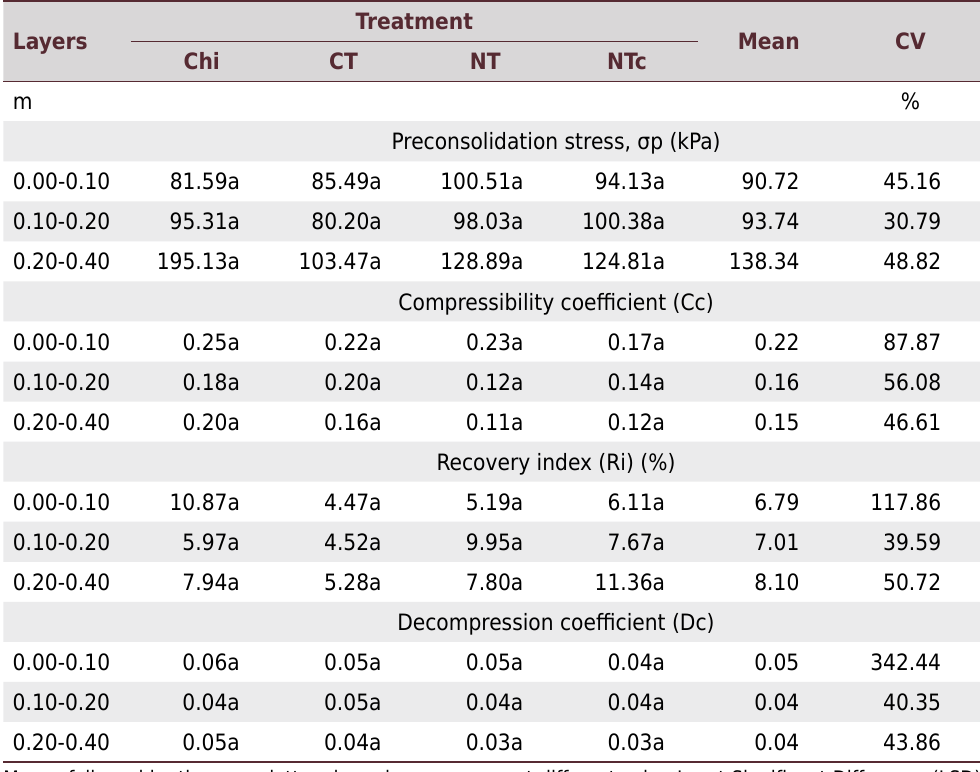
Table 9. Soil preconsolidation stress, compressibility coefficient, recovery index, and decompression coefficient in three soil layers and four soil tillage methods at physiological maturity of cassava crop